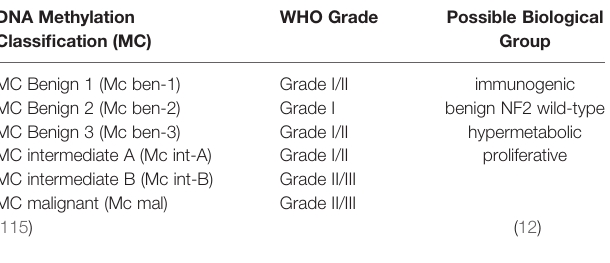
TABLE 2 | Overview of different classi fi cations of meningiomas in latest studies. DNA Methylation WHO Grade Possible Biological Classi fi cation (MC)